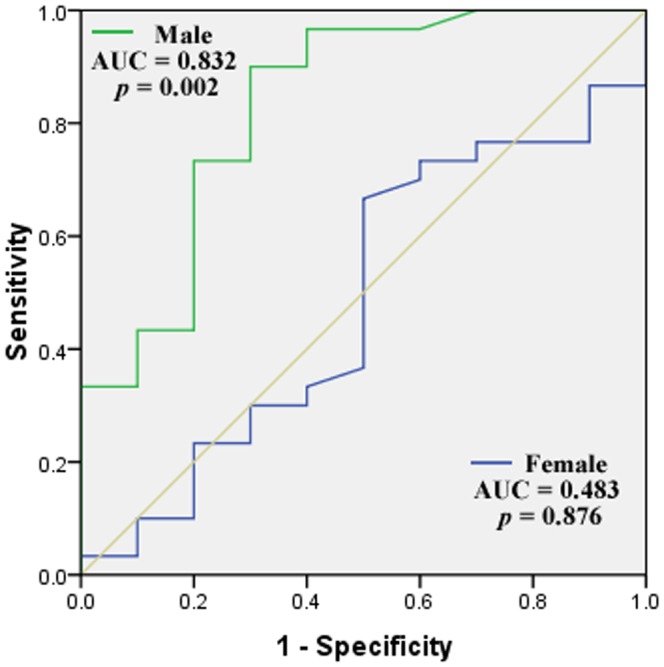
Male specific prediction of SCZ using DRD4 methylation as a diagnostic marker.